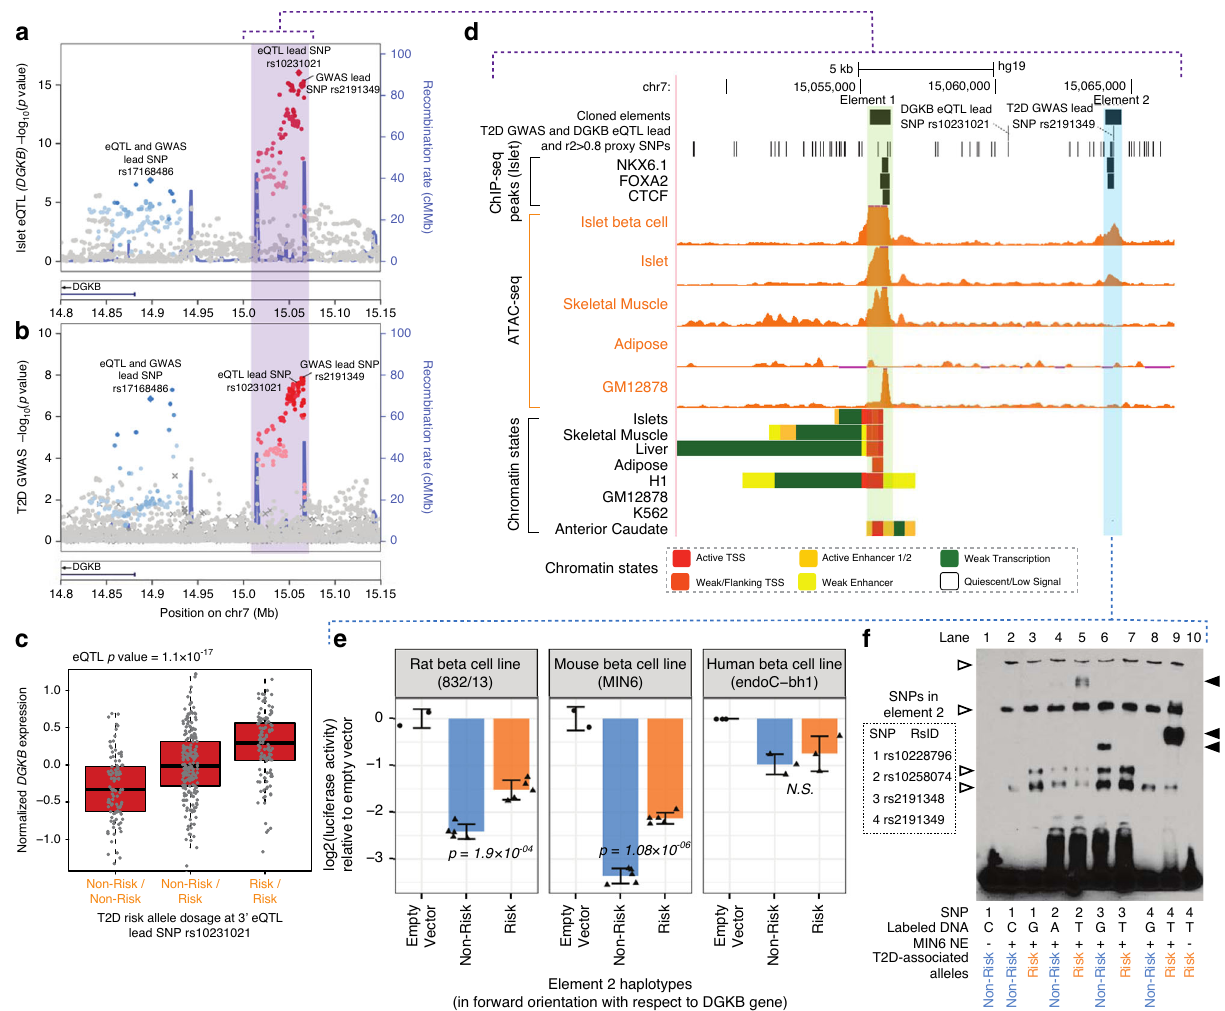
Element 2 haplotypes (in forward orientation with respect to DGKB gene) Fig. 4 Functional assessment of DGKB eQTL locus. a We show the two of the three independent islet eQTL signals that colocalize with identi fi ed independent GWAS variants near the DGKB gene locus (lead SNP rs17168486 referred at as the 5 ′ signal and lead SNP rs10231021 referred to as the 3 ′ signal). These signals colocalize with two independent T2D GWAS signals shown in b , where rs17168486 is referred to as the 5 ′ signal and lead SNP rs2191349 referred to as the 3 ′ signal. LD information was not available for SNPs denoted by (×). The third GWAS variant and the third eSNP are not shown as both are located outside this region and in opposite location with respect to DGKB, showing no evidence of colocalization. c Normalized DGKB gene expression levels relative to the T2D-risk-allele dosage at the 3 ′ islet eQTL for DGKB lead SNP rs10231021. eQTL p -value adjusted to the beta distribution is shown. d Genome browser view of the region highlighted in purple in a and b that contains the 3 ′ DGKB eQTL and T2D GWAS signals. Two regulatory elements (element 1 highlighted in green, element 2 highlighted in blue) overlapping ATAC-seq peaks in islet β -cells (islet single nuclei ATAC-seq 49 ) and bulk islets (islet track represents one islet sample from Varshney et al. 15 ) were cloned into a luciferase reporter assay construct for functional validation. All ATAC-seq tracks are normalized to 10 M reads and scaled from 0 – 15. e Log 2 luciferase assay activities (normalized to empty vector) are shown for in rat (832/13), mouse (MIN6), and human (EndoC- β H1) β -cell lines for the element 2 (cloned in the forward orientation), highlighted in blue in d . The risk haplotype shows signi fi cantly higher ( p < 0.05) activity than the non-risk haplotype in 832/13 and MIN6, consistent with the eQTL direction shown in c . P -values were determined using unpaired two-sided t -tests. f EMSA for probes with risk and non-risk alleles at the four SNPs overlapping the regulatory element validated in e , using nuclear extract from MIN6 cells. Filled arrows, allele-speci fi c binding; open arrows, non-allele-speci fi c binding of proteins to probes. Source data are provided as a Source data fi